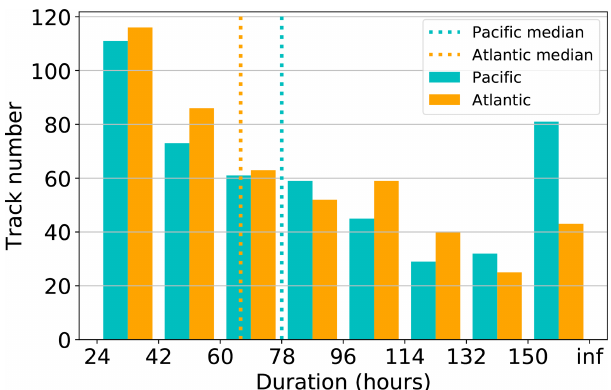
Figure 9. Distribution of track durations (in hours) of AR tracks in the North Pacific (cyan) and North Atlantic (orange). The “inf” label is used to form the right bin edge for the last bin which includes all tracks lasting longer than